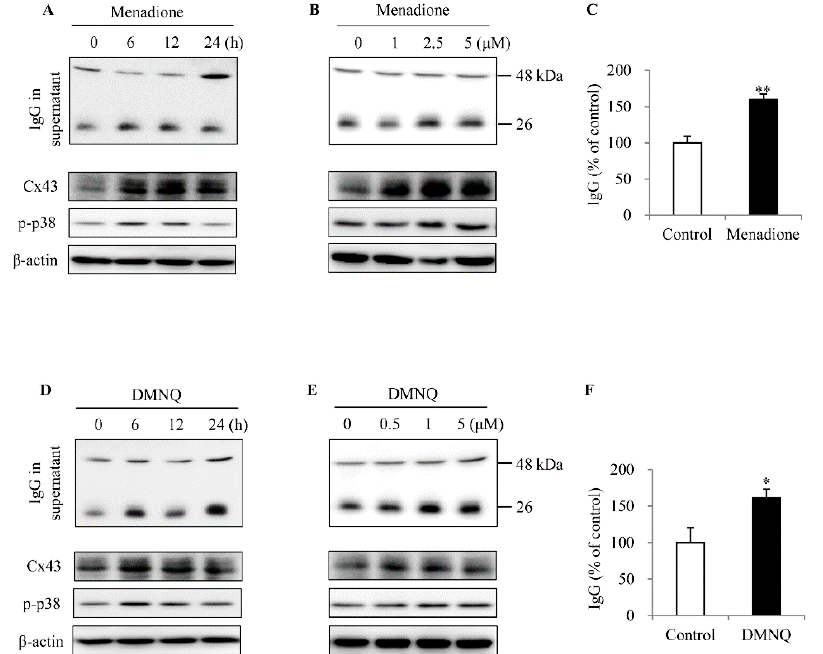
Figure 5. Effect of superoxide donors on IgG production, Cx43 expression and p38 activation in cultured spleen cells. ( A , B , D , E ) Induction of IgG, Cx43 and p38 activation by superoxide donors. Spleen cells isolated from Cx43 +/+ mice were stimulated with 2.5 μ M menadione or 0.5 μ M DMNQ for the indicated time or exposed to the indicated concentrations of the reagents for 24 h. Supernatants and cell lysates were harvested and subjected to Western blot analysis for IgG, Cx43 and p-p38. The quantitation of IgG at 24 h point after treatment with 2.5 μ M menadione and 0.5 M DMNQ was shown in ( C ) and ( F ), respectively. Data shown are mean ± SE ( n = 3). * p < 0.05, ** p < 0.01.